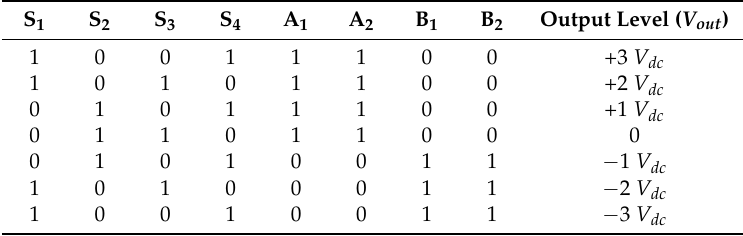
Table 1. Switching states for reduced switch multilevel inverter